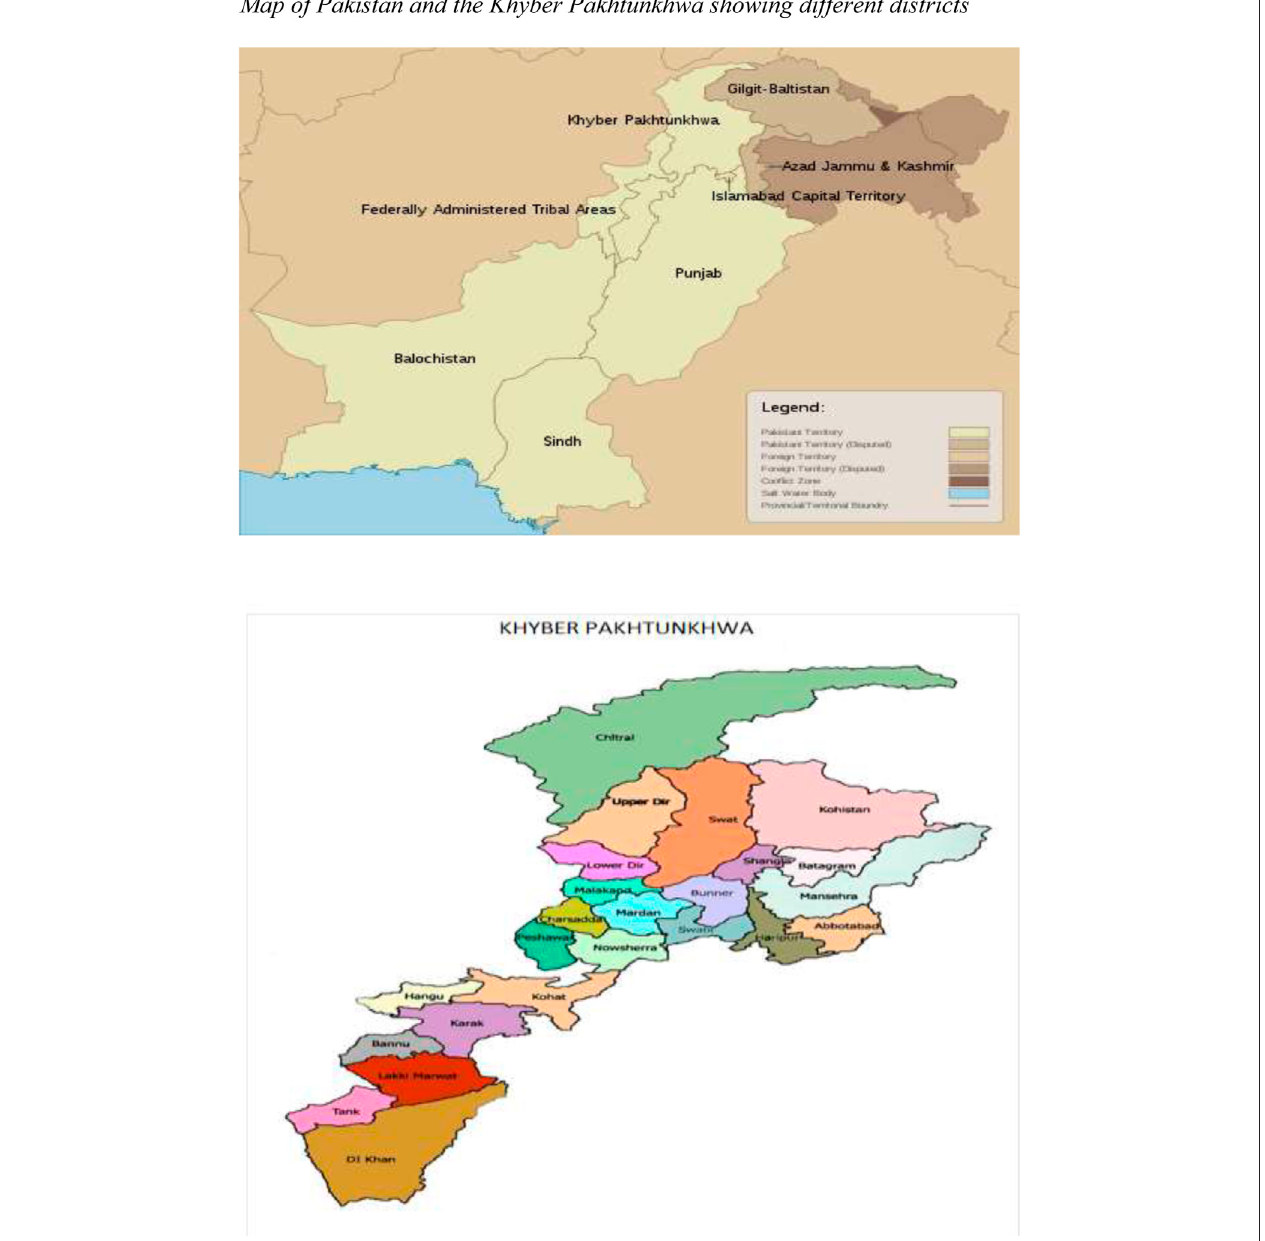
FIGURE 1 | Map of Pakistan and the Khyber Pakhtunkhwa showing different